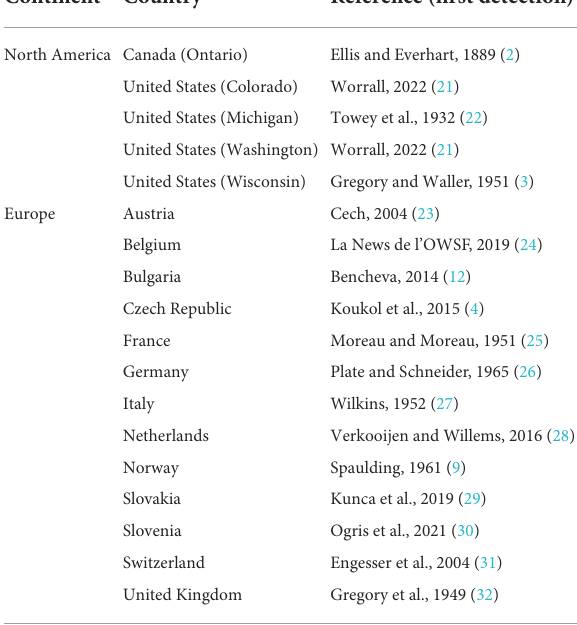
TABLE 1 Geographical distribution of C. corticale